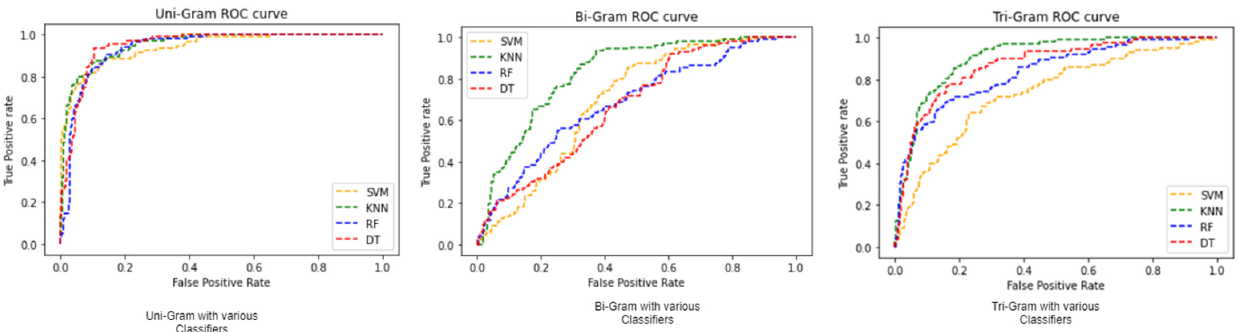
Figure 6. ROC for SVM, KNN, RF, and DT classifiers.